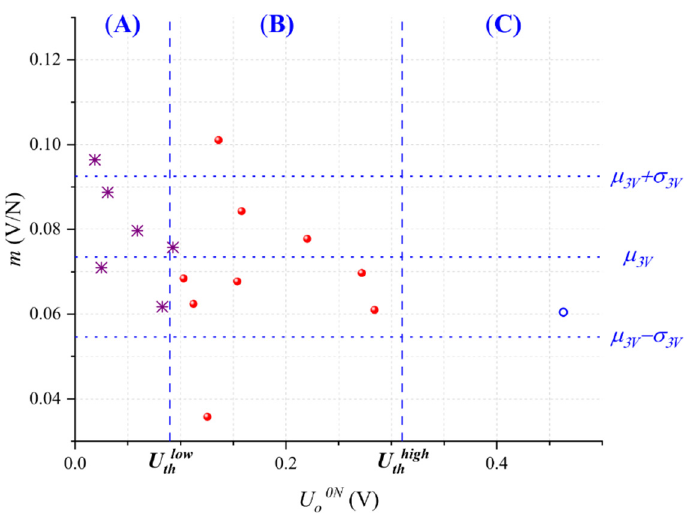
Figure 9. Sensitivity ( m ) as a function of the output voltage at null force ( U o0N ) for each specimen after compensation. Experimental data resulting from the control stage. Different markers were used for the sensors of Regions (A) and (C) after compensation.